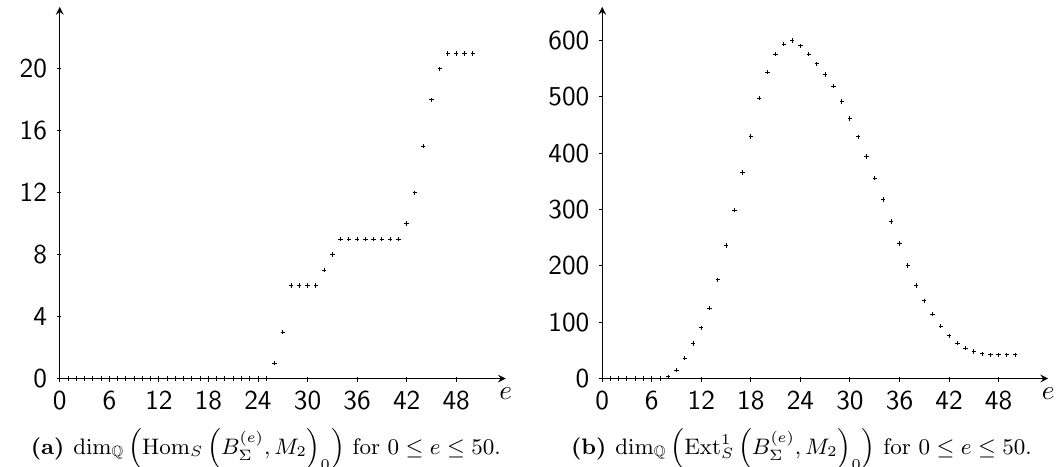
Figure 7. Computing the sheaf cohomologies of f M 2 with plesken .